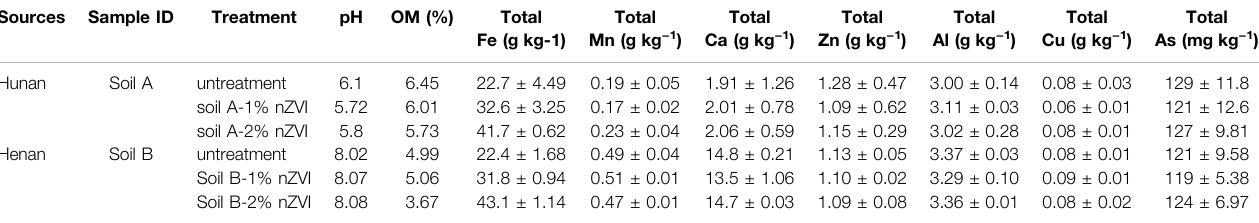
TABLE 1 | Selected properties of 2 contaminated soils and 4 nZVI treatment soils after 56 days ( < 250 μ M particle size). Sources Sample